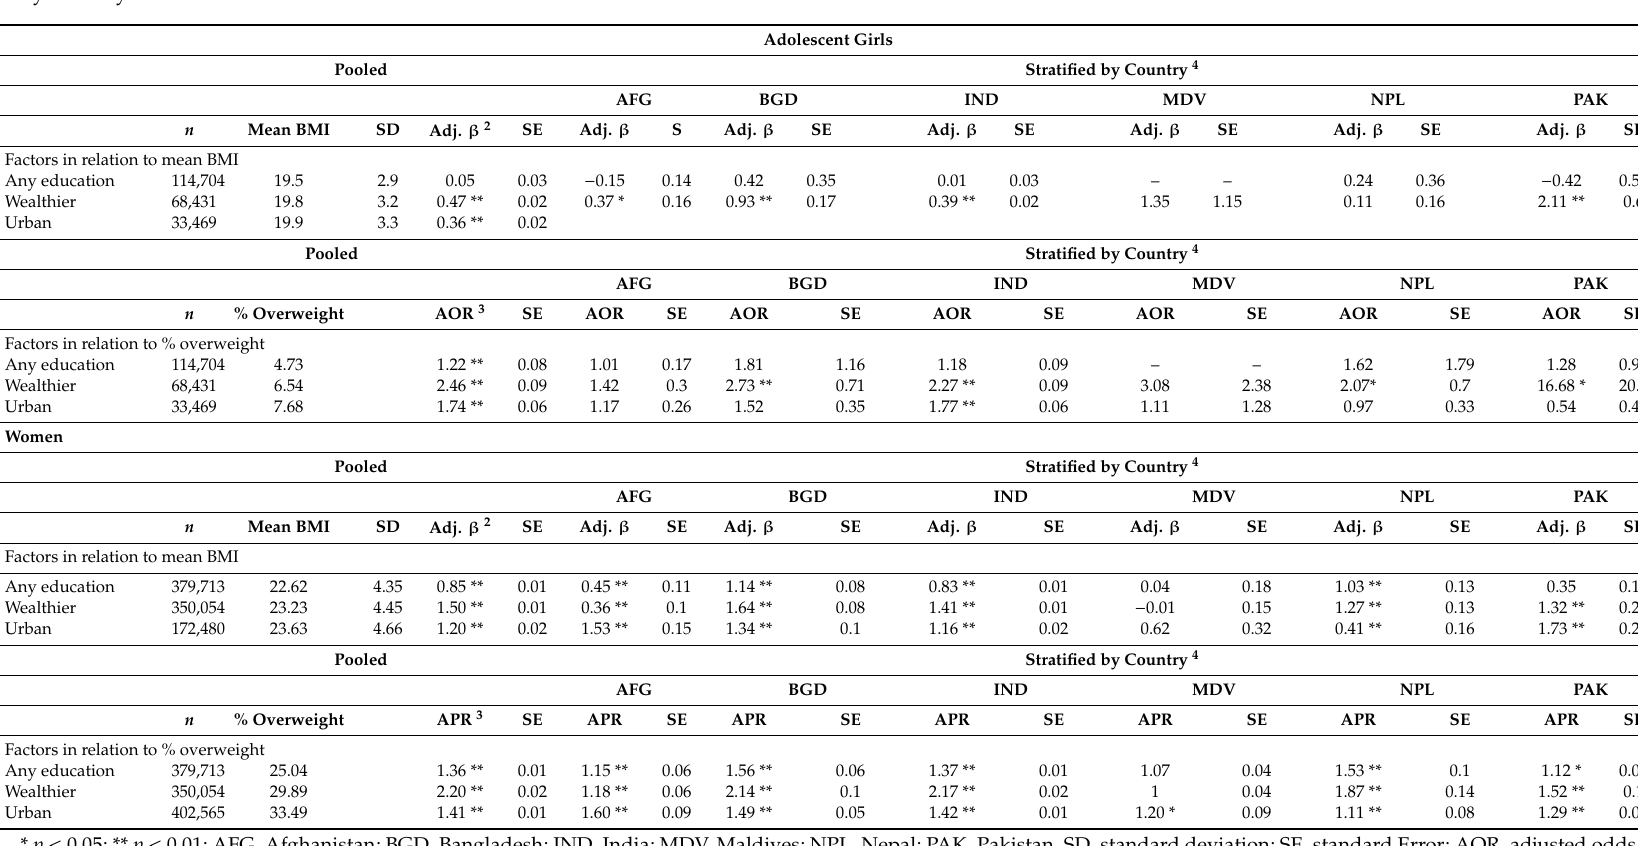
Table 4. Relationship between girls’ and women’s body mass index (BMI) and prevalence of overweight 1 with three key factors, presented pooled and stratified by